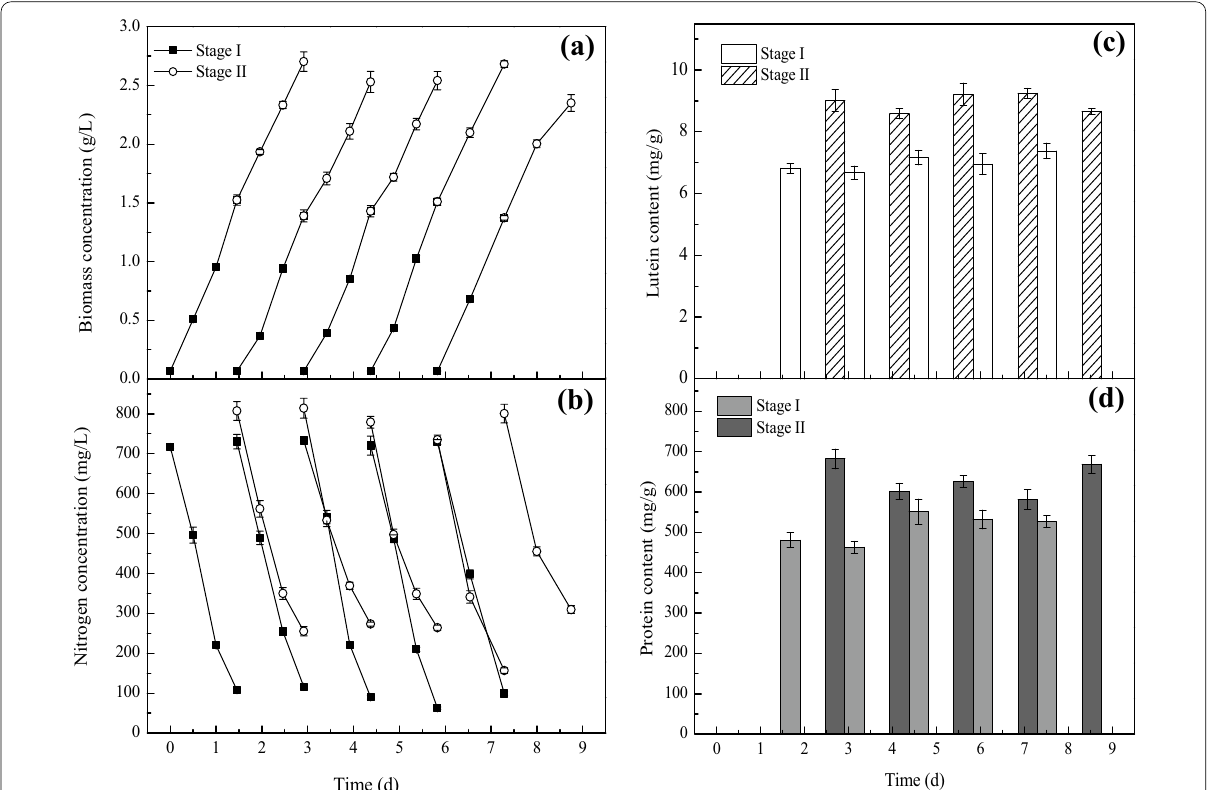
Fig. 4 Cell growth and lutein and protein accumulation of C. sorokiniana FZU60 under two‑stage cultivation strategy. a Biomass concentration; b nitrogen concentration; c lutein content; d protein